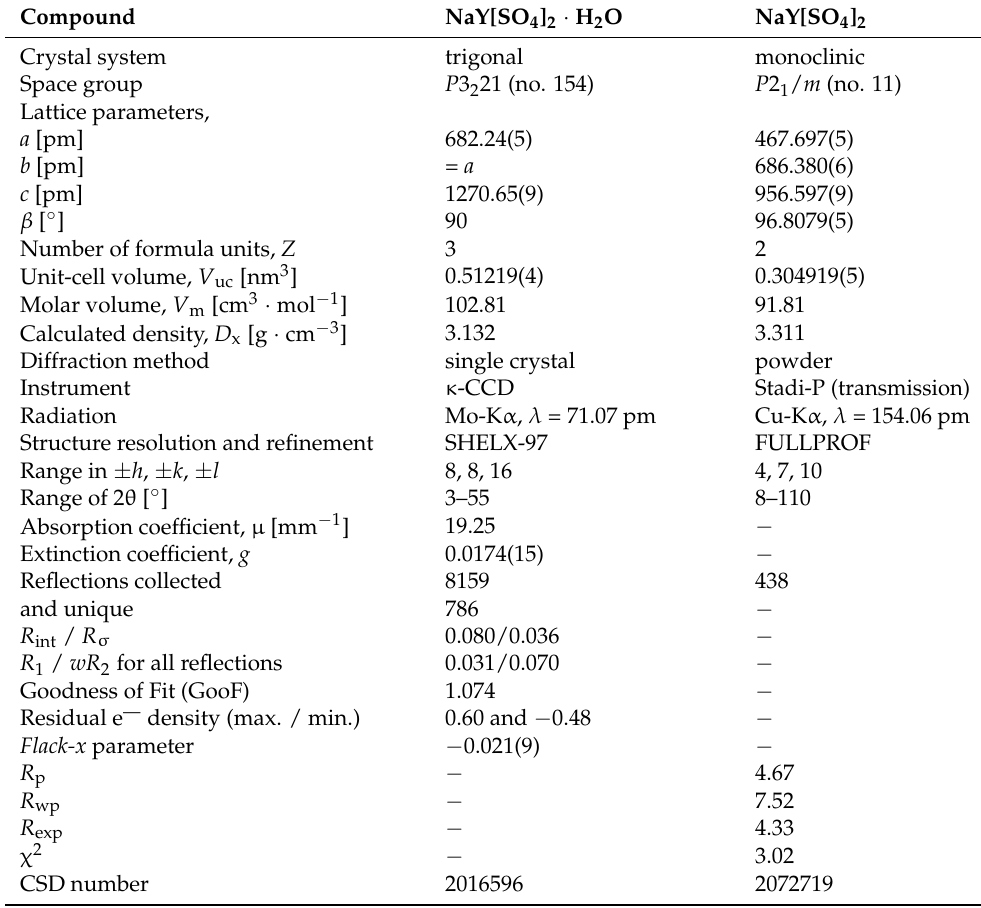
Table 1. Crystallographic data of NaY[SO 4 ] 2 · H 2 O ( left ) and NaY[SO 4 ] 2 ( right